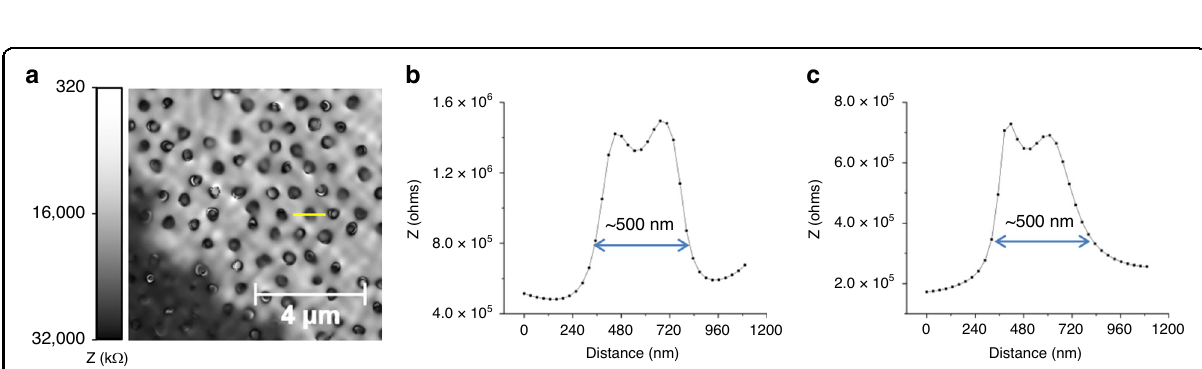
Fig. 5 Submicrometric spatial resolution with high electric contrast obtained by el-epi-MISS measurements. a El-epi-MISS impedance map at 0.5 Hz. b Pro fi le corresponding to the yellow line and indicating a generic, individual hole in the TiO 2 layer. c The same pro fi le corresponding to an individual hole in the TiO 2 layer at 1.6